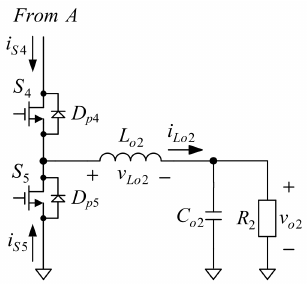
Figure 2. SR buck